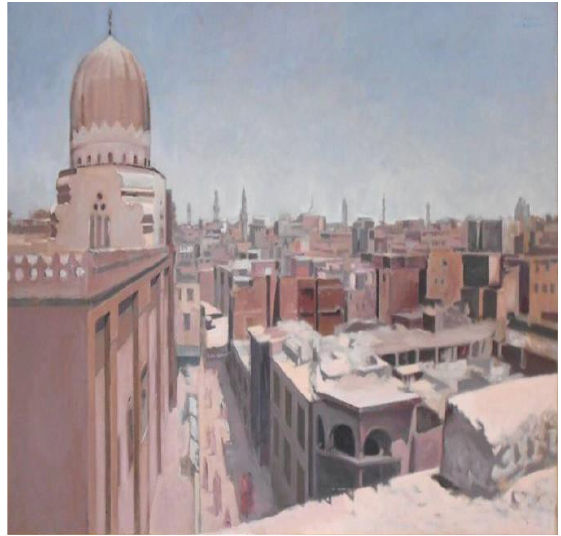
Fig. 28 Oil painting on canvas 2000 Fig. 29 view from Gamalia 1 Oil on canvas 130